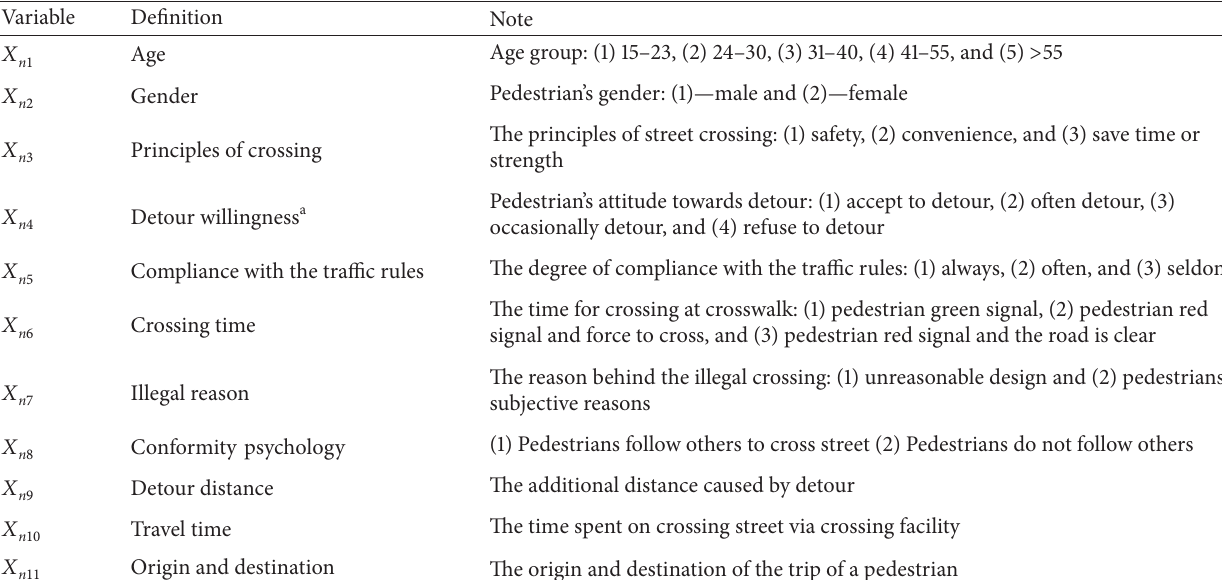
Table 1: Definition of variables.